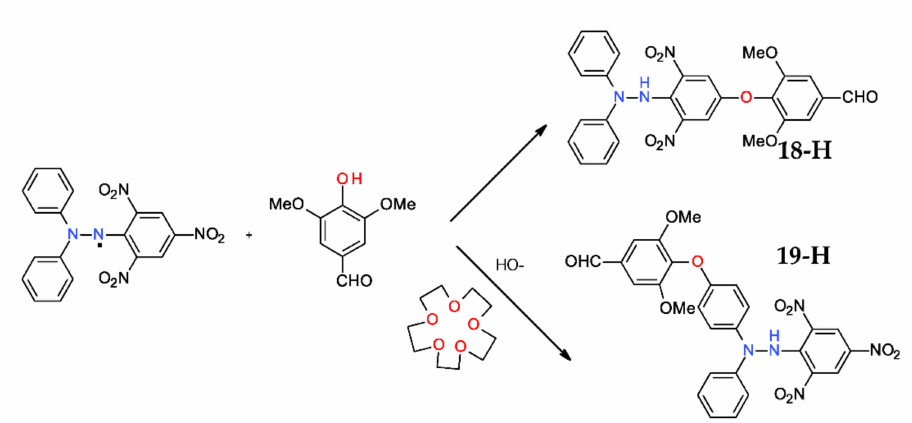
Figure 10. Reaction of DPPH · with